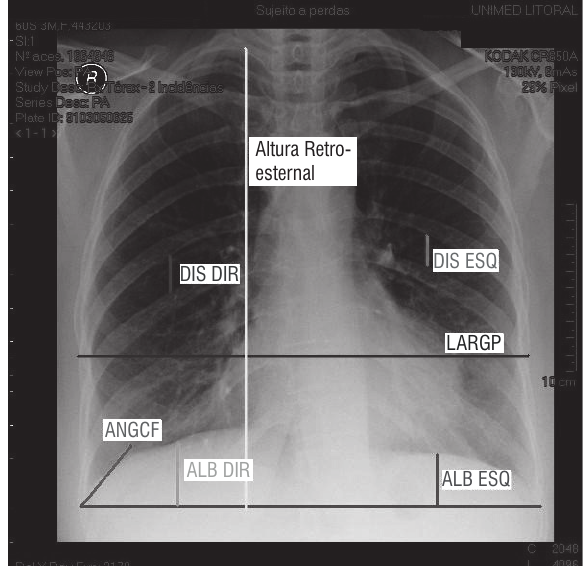
Figura 1 - Imagem das medidas analisadas na radiografia Fonte: Dados da